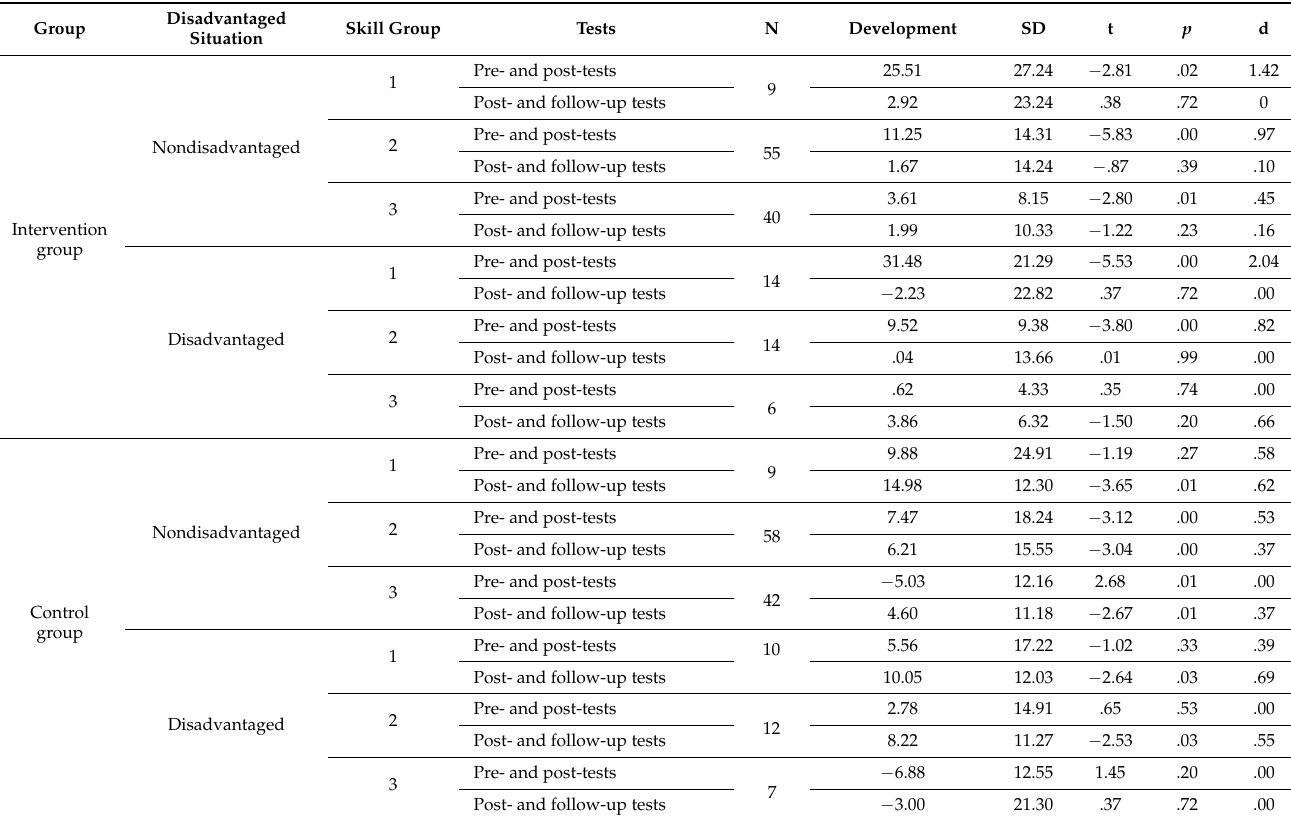
Table 5. Development of students in the intervention and control groups between pre- and post-tests and between post- and follow-up tests on a manifest level in standard deviation units by skill group and disadvantaged